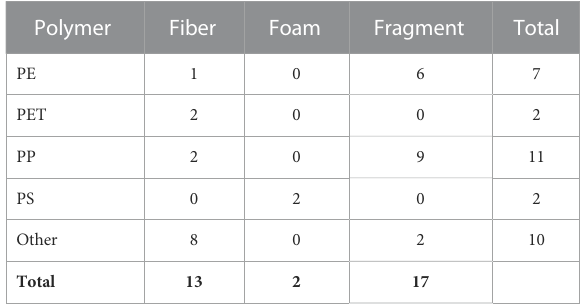
TABLE 3 Distribution of microplastic polymers by morphologies. PE, Polyethylene; PET, Polyethylene terephthalate; PP, Polypropylene; PS, Polystyrene; Other includes a range of polymer types that can be referenced in Supplementary Data Sheet